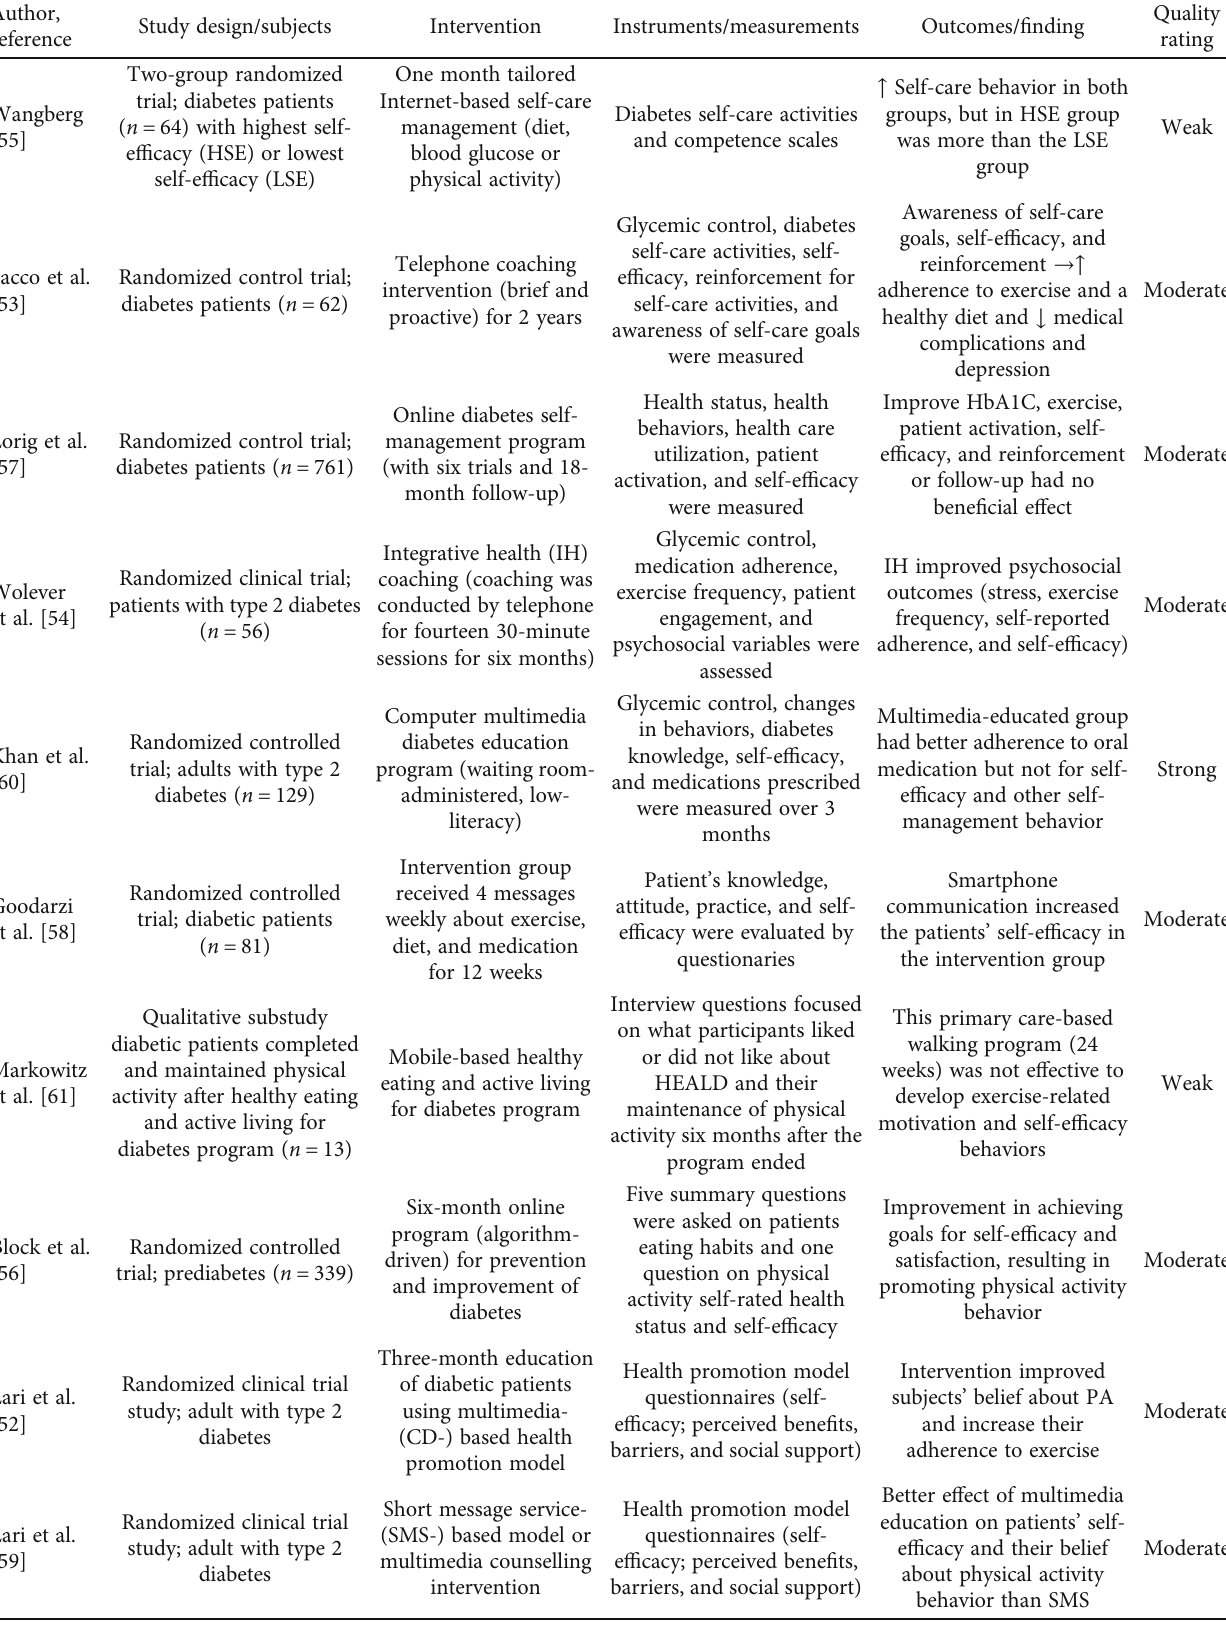
Table 4: Characteristics of studies using multimedia and